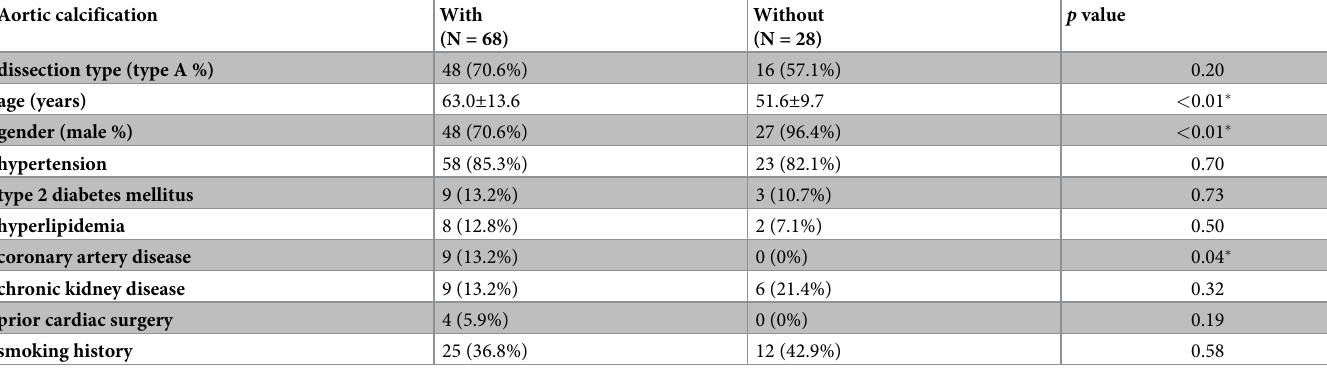
Table 3. Comparison between acute aortic dissection patients with or without aortic calcification.